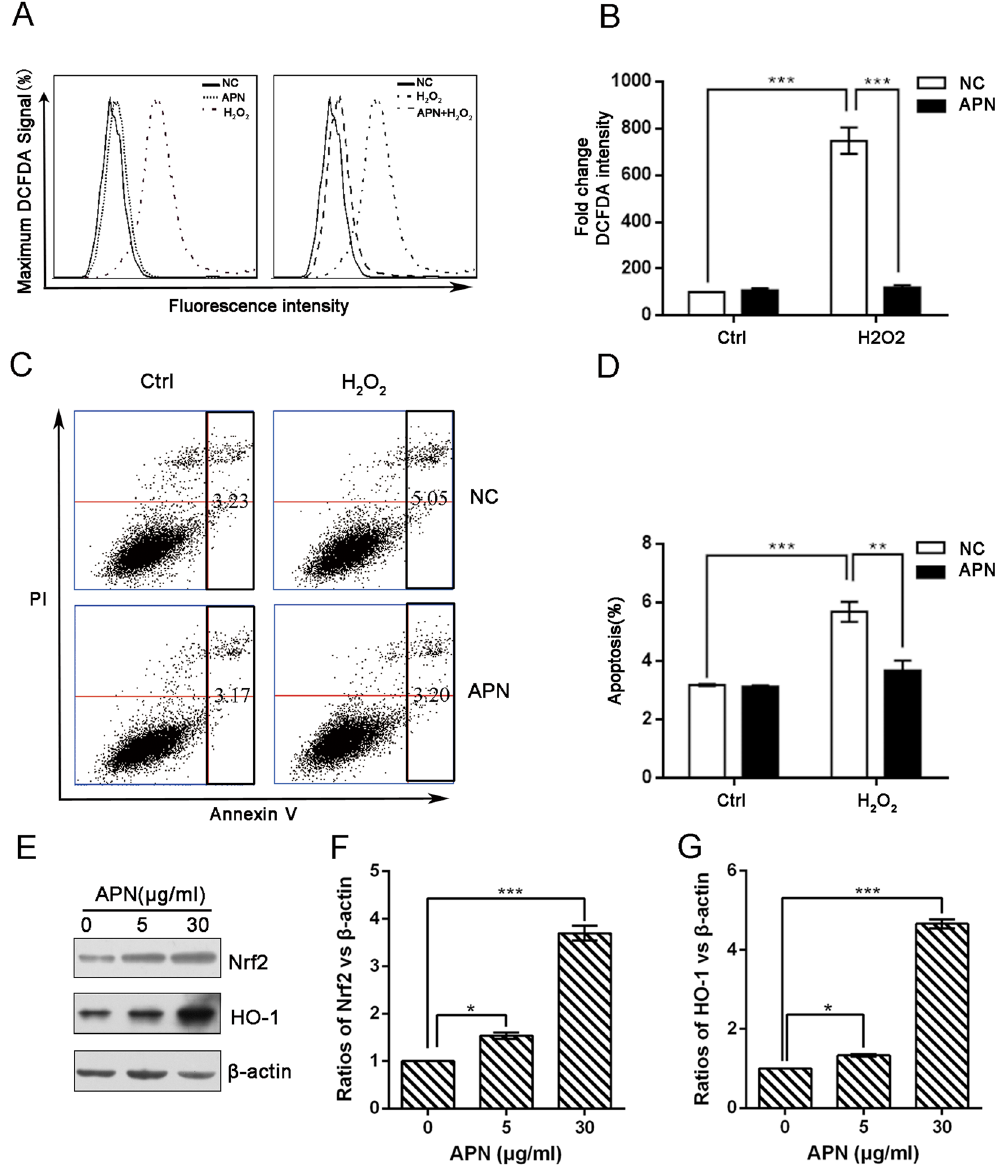
Figure 2. APN inhibits H 2 O 2 -induced ROS generation and apoptosis in C2C12 cells. C2C12 cells were pretreated with 30 μ g/mL APN for 24 h and then incubated with or without 5 mM H 2 O 2 for 0.5 h. ( A ) To monitor ROS production, cells were incubated at 37 °C in the dark for 30 min with fresh culture medium containing 10 μ M DCFH-DA. ROS generation was measured using a flow cytometer. ( C ) Cells were also stained with annexin V-FITC and propidium iodide (PI), and the percentages of apoptotic cells were then analyzed via flow cytometric analysis. ( B , D ) The results are presented as the mean ± SEM values obtained from three independent experiments ( ** p < 0.01, *** p < 0.001). ( E ) Induction of Nrf2 and HO-1 expression by APN in C2C12 cells. The C2C12 cells were incubated with various concentrations of APN for 24 h. Image J densitometric analysis of the Nrf2/ β -actin ratios ( F ) and HO-1/ β -actin ratios ( G ) from the immunoblots is shown (data from three independent experiments) ( * p < 0.05, *** p <